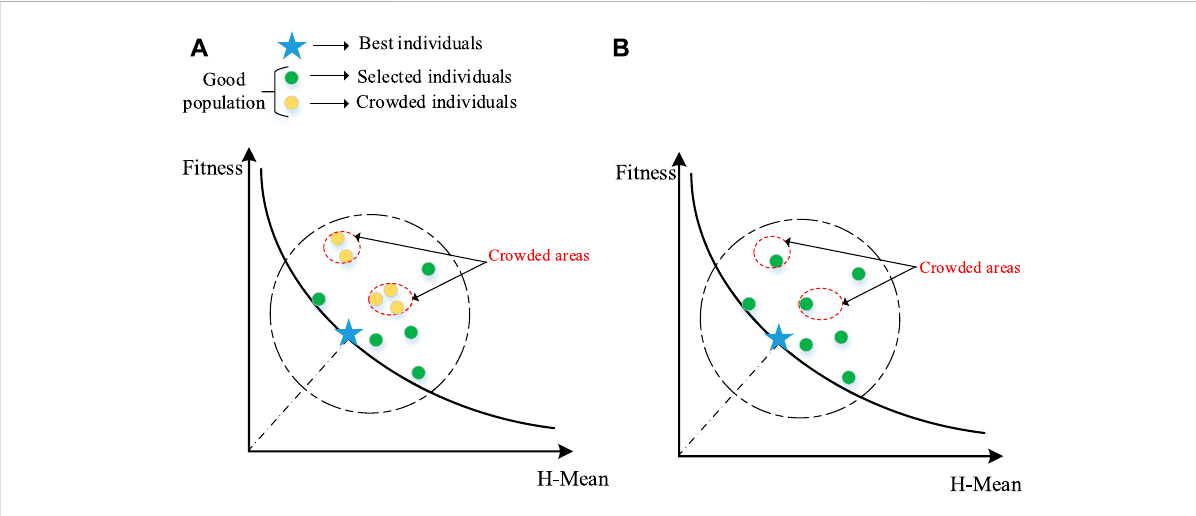
FIGURE 1 The simulative spatial dispersion of good subpopulations: (A) Before employing the crowding strategy based on H-Mean, (B) After employing the crowding strategy based on